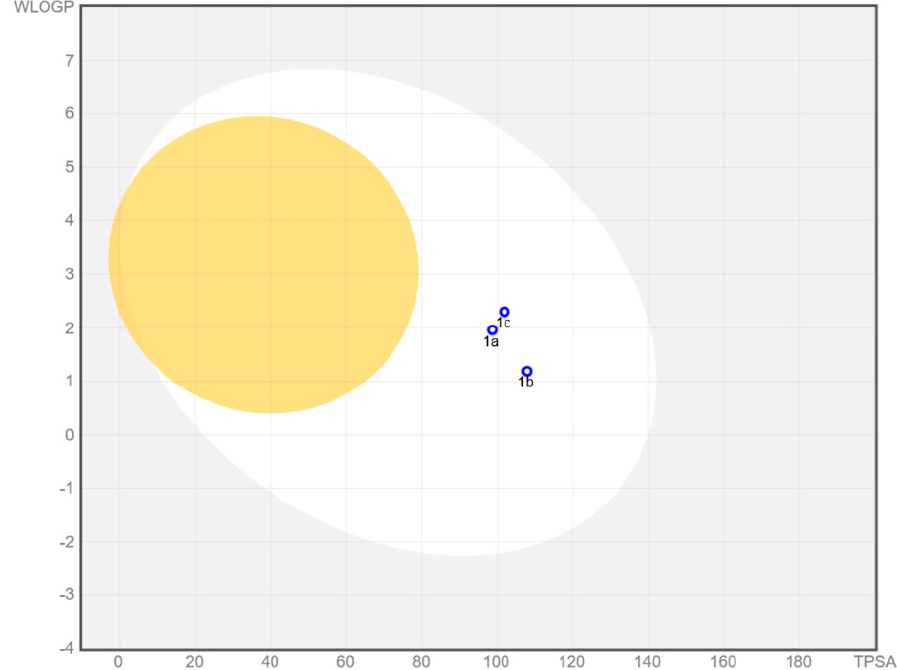
Figure 13. BOILED-Egg diagram for all compounds (lipophilicity (WLOGP) and polarity (tPSA), human intestinal absorption (white area) and blood–brain barrier permeation (yellow area).